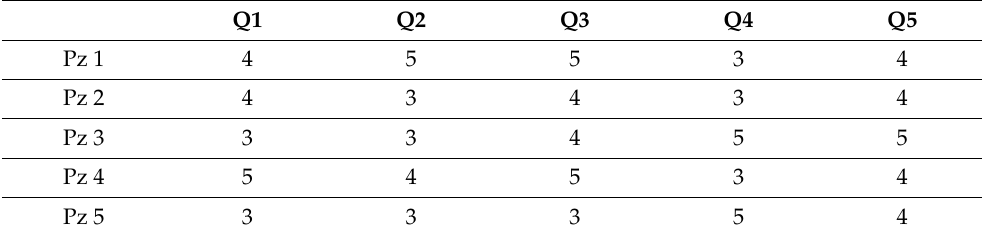
Table 1. Patients’ questionnaire